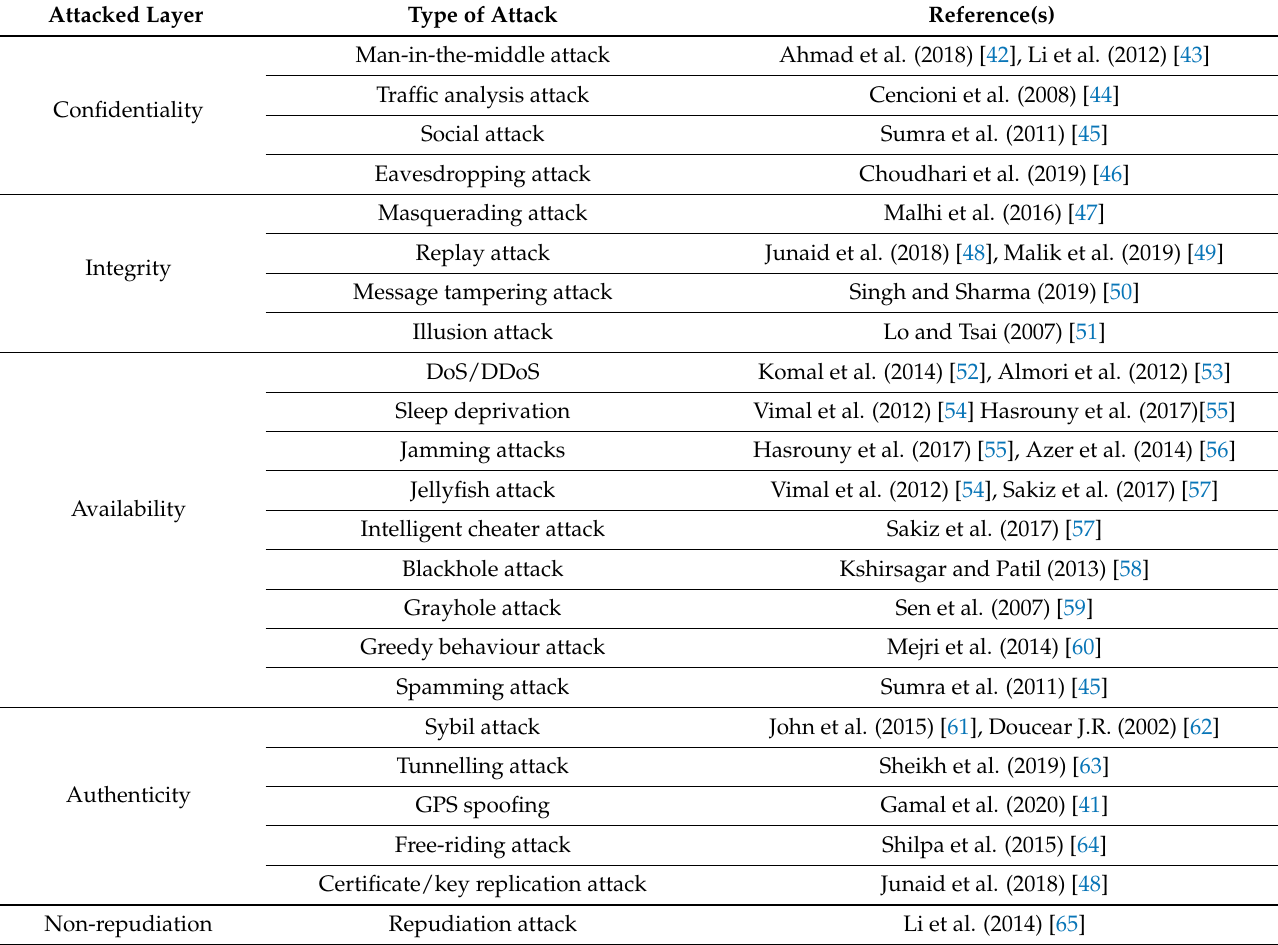
Table 1. Attack classification based on security